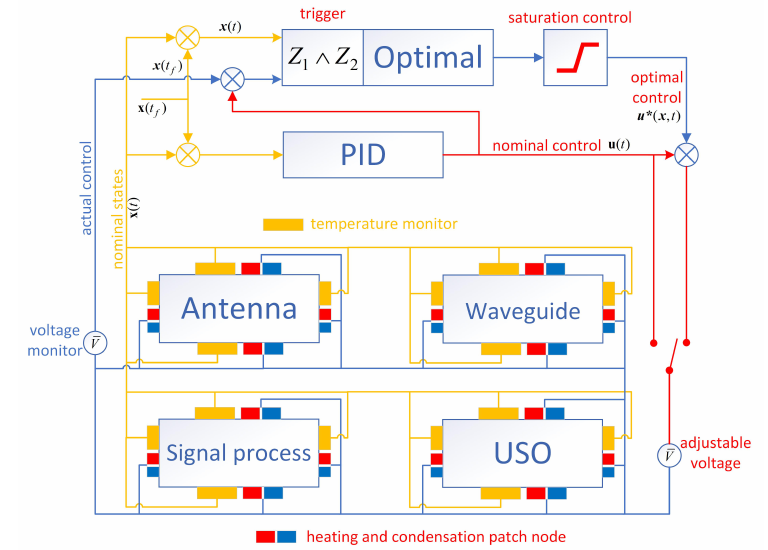
Figure 2. Structure of the trigger-based thermal control